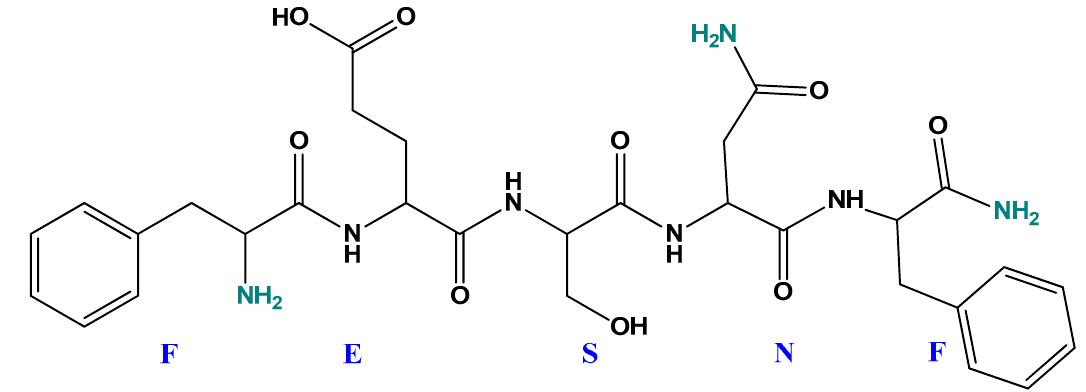
Figure 2. Chemical structure of pentapeptide under study.